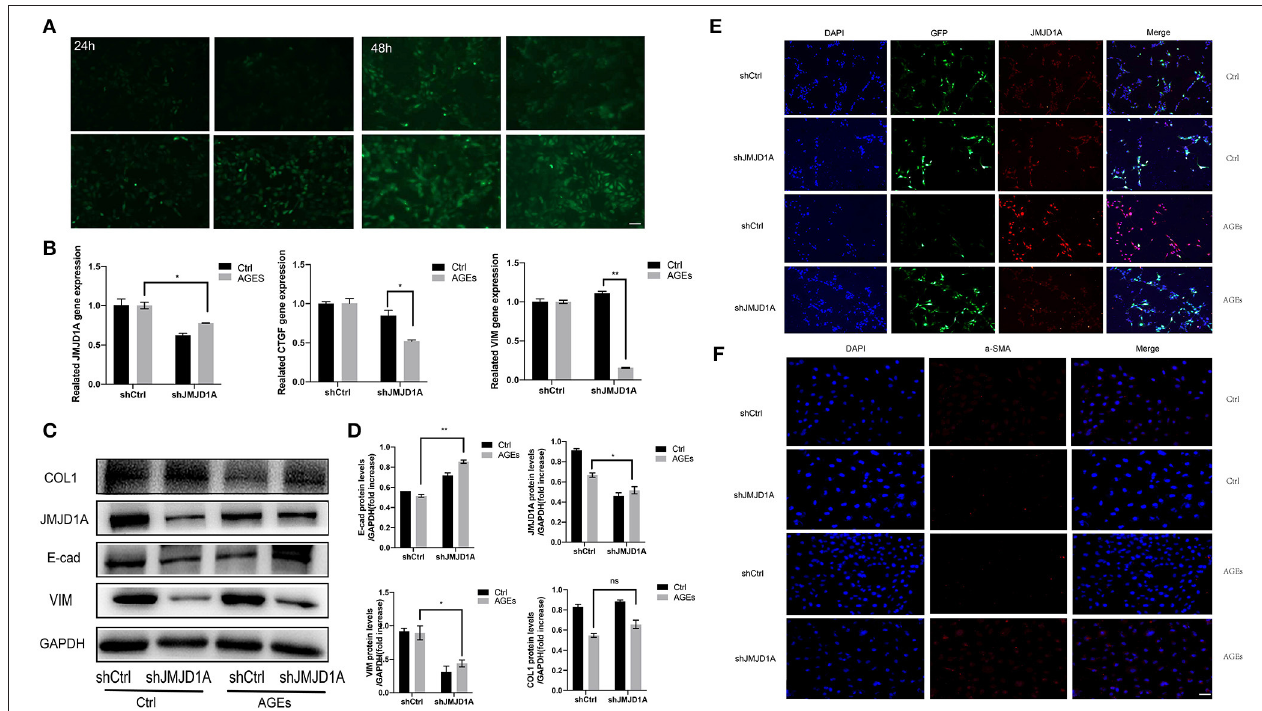
FIGURE 5 | Knockout of JMJD1A inhibited the expression of fibrosis-related factors in HK-2 cells stimulated by AGEs. (A) The JMJD1A knockout lentivirus vector was successfully constructed and stably transfected into HK-2 cells. The virus infection efficiency was observed by inverted fluorescence microscope. (B) After cultured with 400 µ g/ml AGEs for 72h, the expressions of JMJD1A, CTGF, and VIM in HK-2 cells stably transduced by shJMJD1A and shCtrl were detected by RT-qPCR ( n = 3, * p < 0.05, ** P < 0.001). (C,D) After being cultured with 400 µ g/ml AGEs for 72h, the expressions of COL1, JMJD1A, E-cad, and VIM in HK-2 cells stably transduced by shJMJD1A and shCtrl were detected by Western blot ( n = 3, * p < 0.05, ** p < 0.001). (E,F) Immunofluorescence was used to detect the expression of fibrosis-related factors JMJD1A and a-SMA, compared with the AGEs shCtrl group, the fibrosis related factors a-SMA and JMJD1A in AGEs shJMJD1A group were significantly lower (scale bar, 100 µ